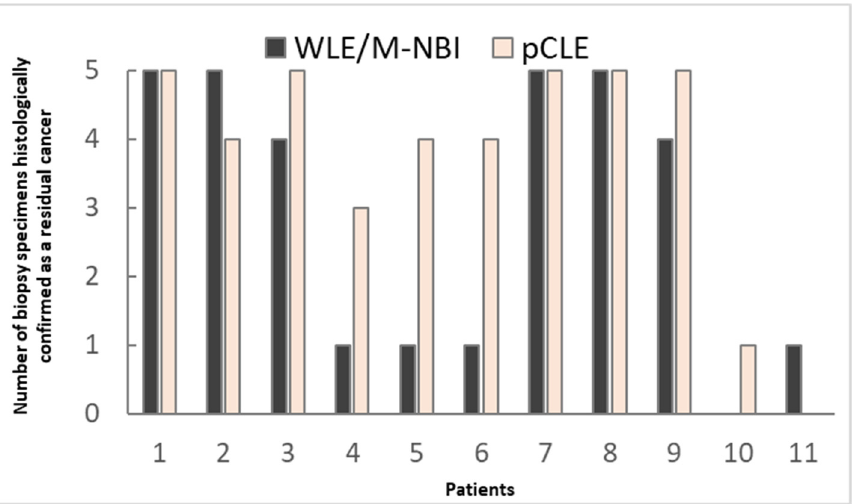
Figure 3. Comparison of the number of biopsy specimens histologically confirmed as containing residual cancer on WLE/M-NBI versus pCLE. GC, gastric cancer; M-NBI, magnified narrow-band imaging; pCLE, probe-based confocal laser endomicroscopy; WLE, white-light endoscopy. Three lesions were predicted to have residual GC on WLE/M-NBI but not pCLE. On the actual biopsy, residual GC was found in only one of the three lesions. Three lesions were suspected to have residual GC on pCLE but not on WLE/M-NBI. In the actual biopsy, residual GC was found in two of the three lesions. The remaining six lesions were